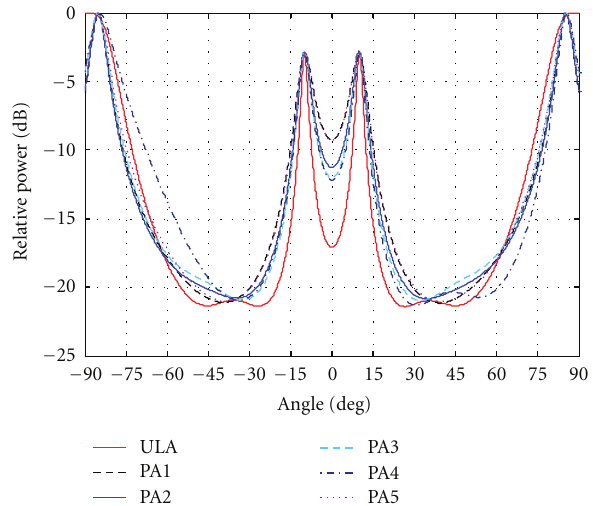
Figure 3: The MVDR spectrum for the ULA and di ff erent PA configurations, DOAs ( − 85 ◦ , − 10 ◦ , 10 ◦ , 85 ◦ ).